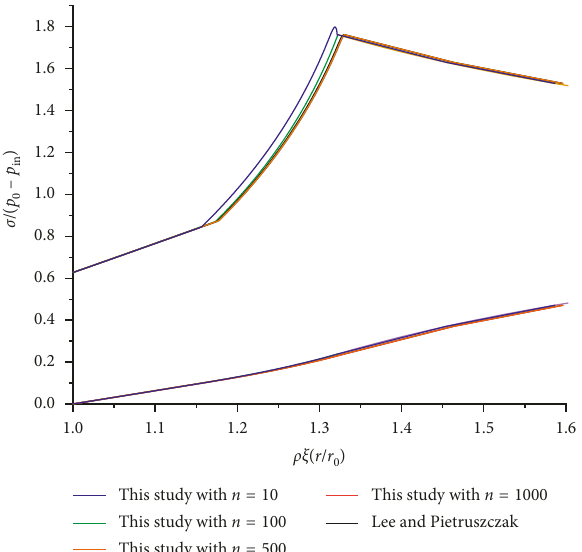
Figure 10: Variation of the dimensionless radial and circumfer- ential stresses with the change of c p Hoek–Brown rock mass.